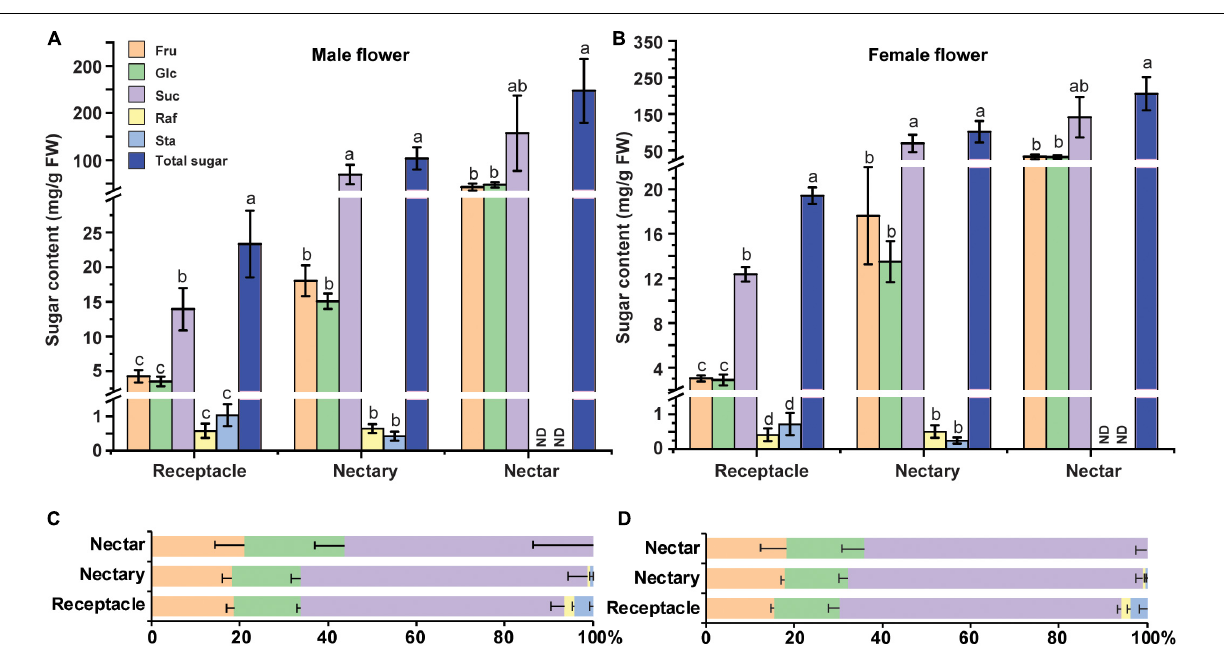
FIGURE 5 | Sugar content in male and female cucumber flowers at anthesis. Sugar content (A,B) and sugar distribution (%) (C,D) in receptacle, nectary, and nectar of male (A,C) and female flowers (B,D) at anthesis. Fru, fructose; Glc, glucose; Suc, sucrose; Raf, raffinose; Sta, stachyose; FW, fresh weight. ND, not detected. For each sample in this figure, ten flowers were collected and combined as a sample. Mean values ± SE of three independent biological replicates were shown. Statistical analyses were performed using one-way ANOVA followed by multiple comparisons using the Fisher’s LSD method ( P -value < 0.05) in each